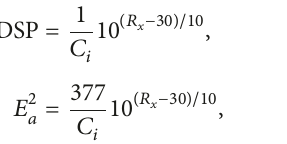
Figure 23: CDFs of SAR peak 10 various values of 𝑇 𝑥 .